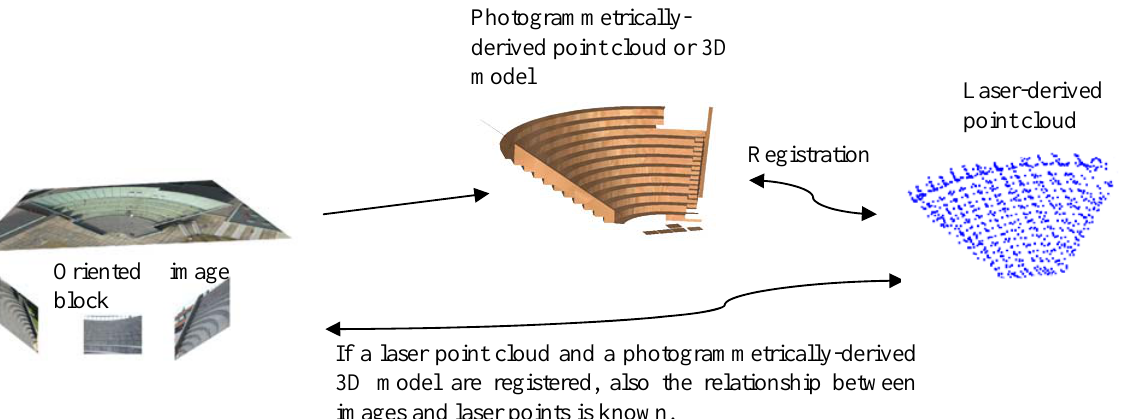
Figure 3. The relative orientation of an image block and a laser point cloud can be solved through the 3D object